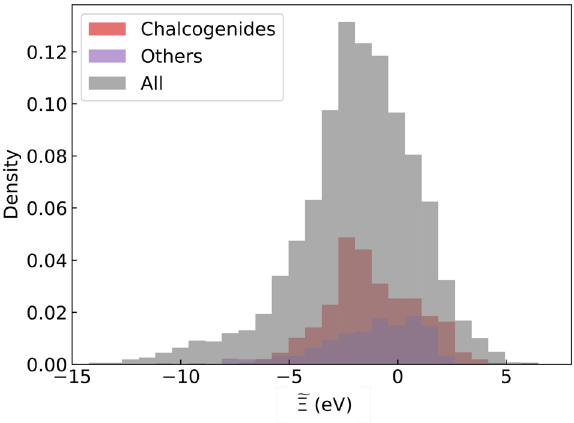
Fig. 1 Histogram of deformation potential estimator. Histograms of the estimators of the gap deformation potential ( e Ξ gap ) for different chemical systems (All, Chalcogenides, and Others as de fi ned in the main text). The values are calculated within the PBE